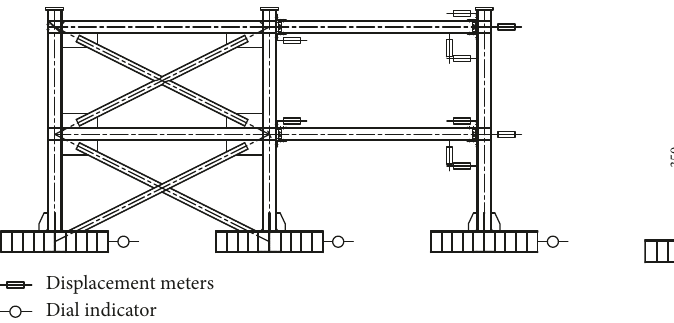
Figure 4: Measurement of displacement.